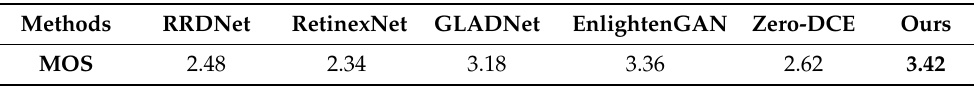
Table 5. The mean opinion scores (MOS) of different methods in user study. The best result is highlighted in boldface.